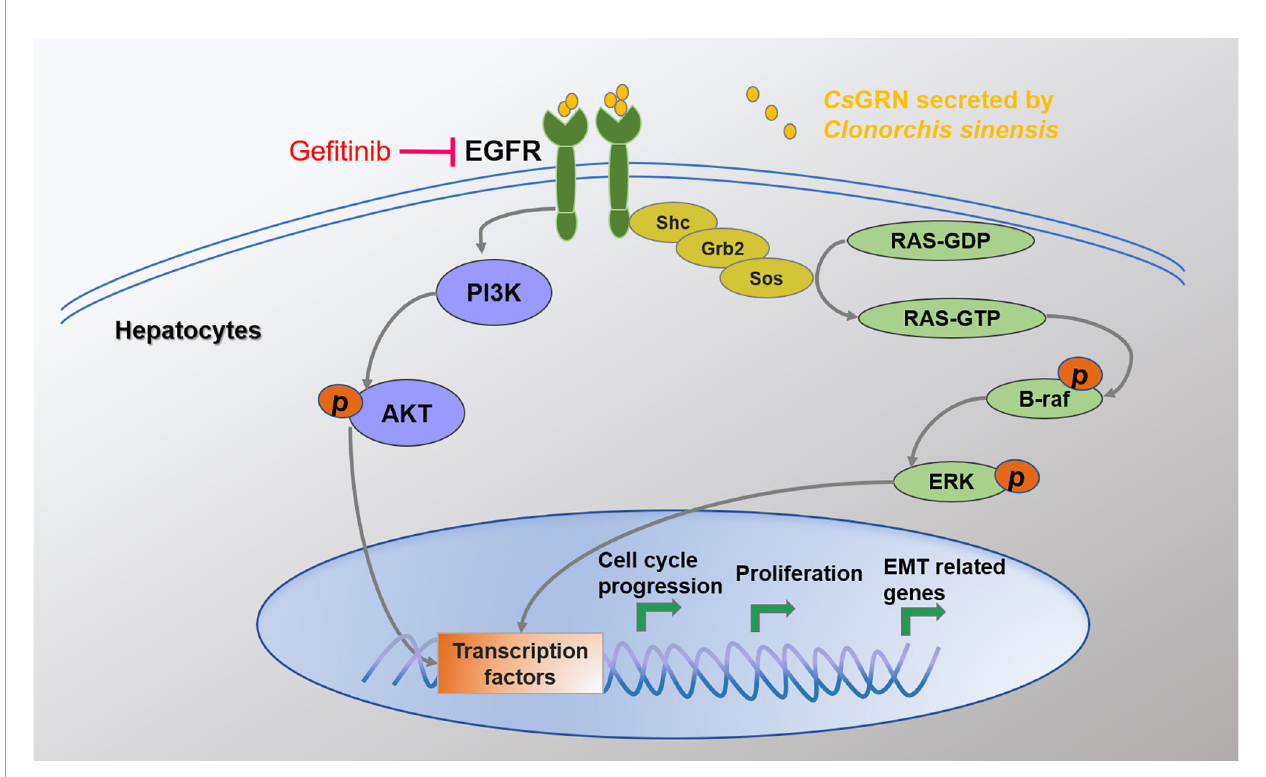
FIGURE 8 | The mechanism of CsGRN in promoting malignant transformation of